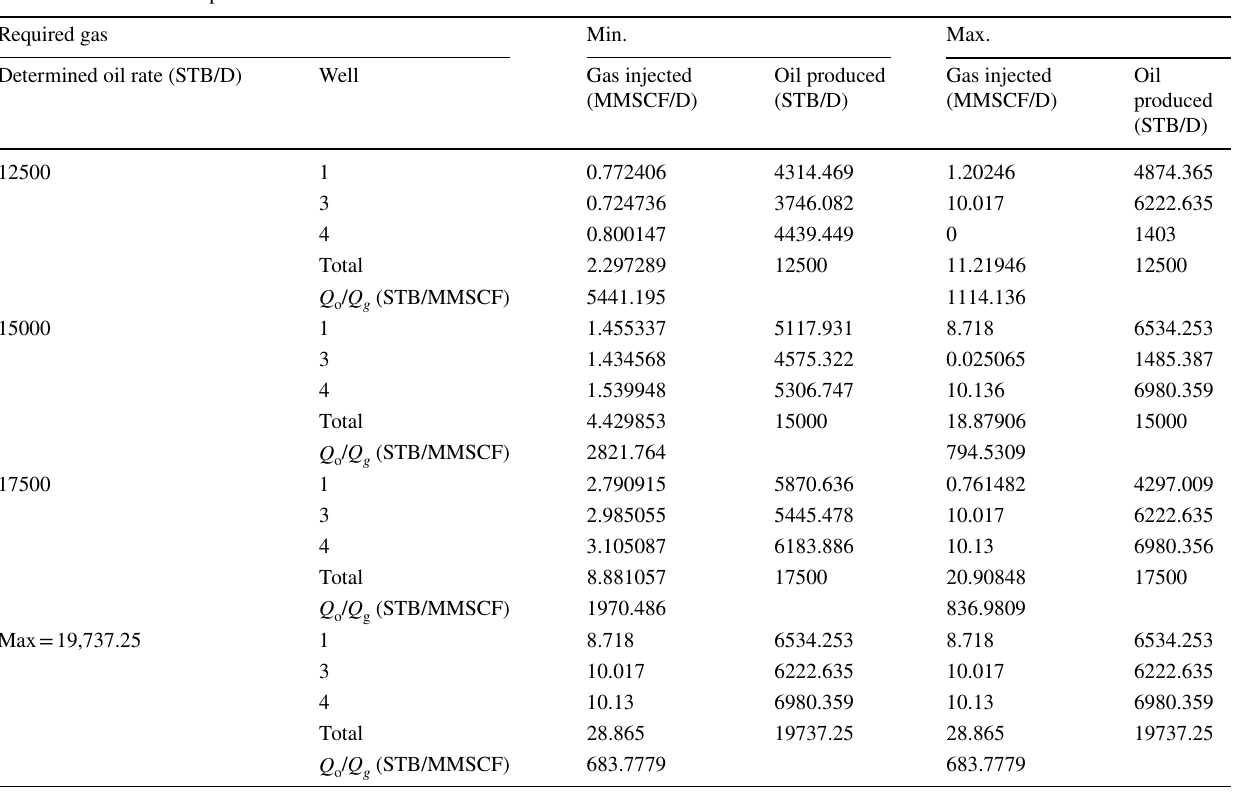
Table 9 Gas allocation optimization for wells of the field at different oil flow rates Required gas Min.